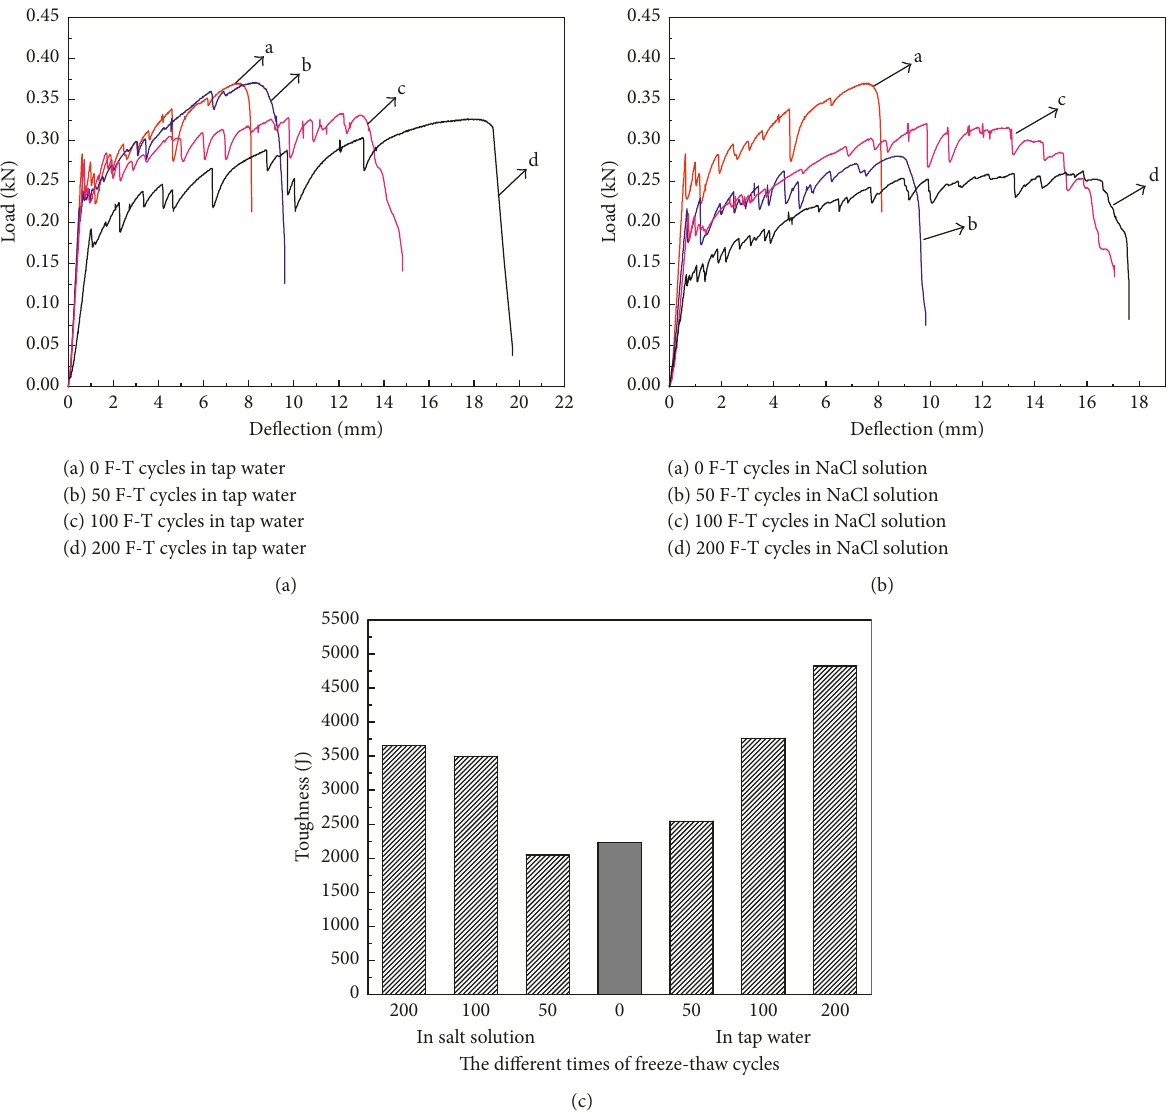
Figure 6: The load-deflection of ECC (50% FA) subjected to different freeze-thaw cycles: (a) in tap water, (b) in sodium chloride (NaCl) solution, and (c) the corresponding toughness with different times of freeze-thaw